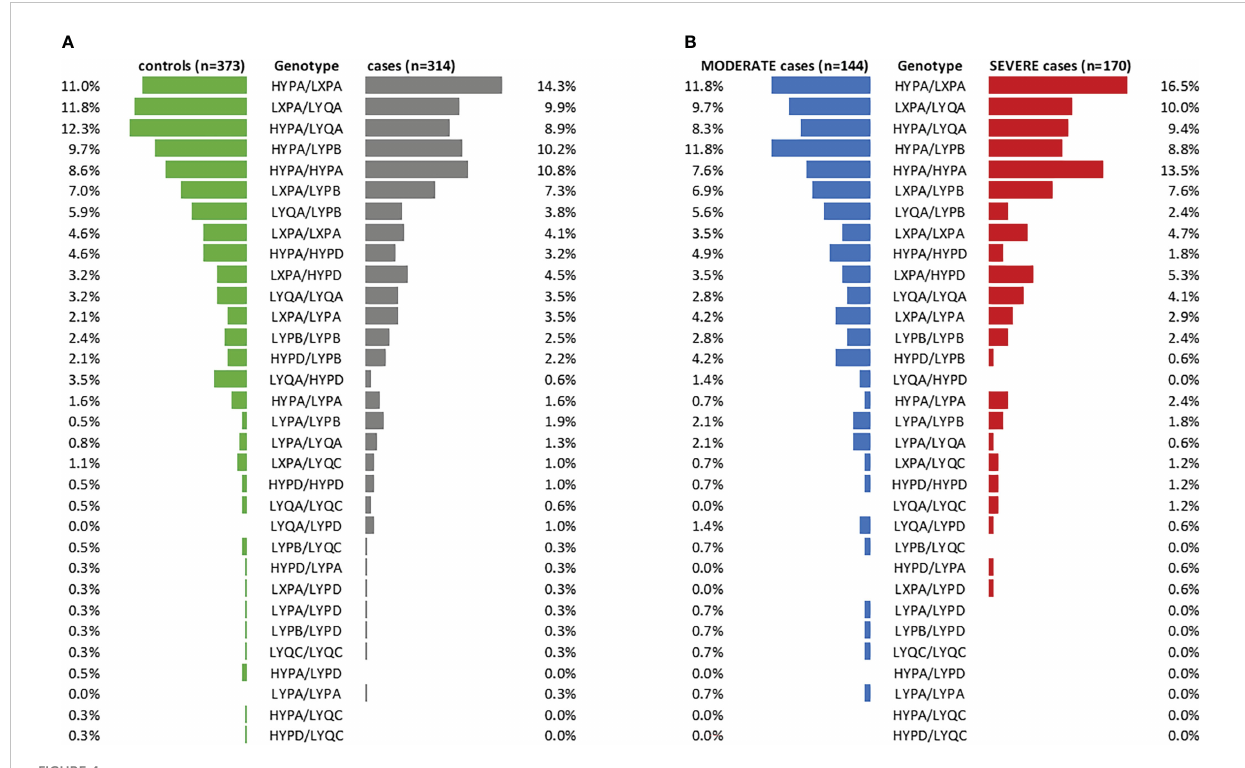
FIGURE 4 Frequencies of long MBL2 haplotype combinations in cases and controls. (A) Strati fi cation of the merged COVID-19 cohorts (CAM and BUD) according to cases and controls (controls: green, cases: grey). (B) Cases strati fi ed according to disease severity (MODERATE: blue, SEVERE: red). n,